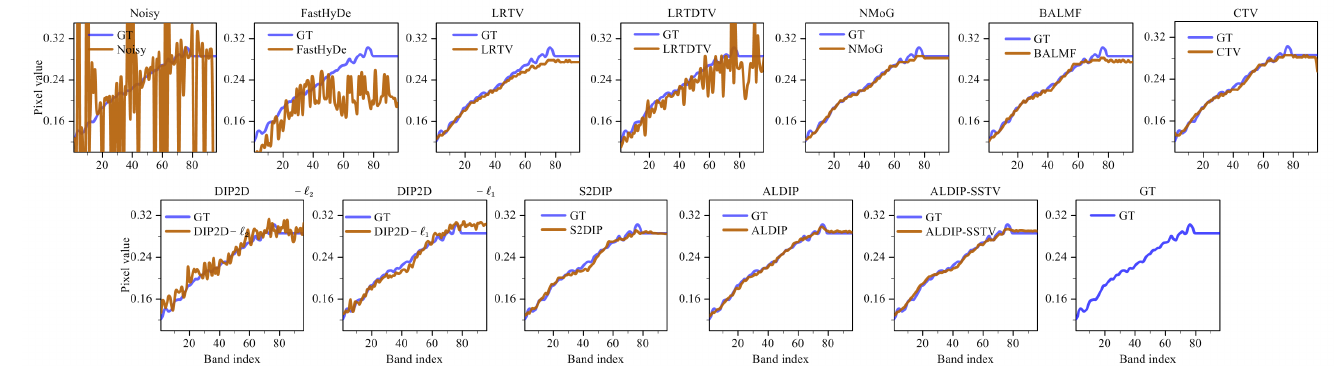
Figure 7. Spectral curves of methods for comparison at pixel (52,59) on Pavia Centre dataset (case